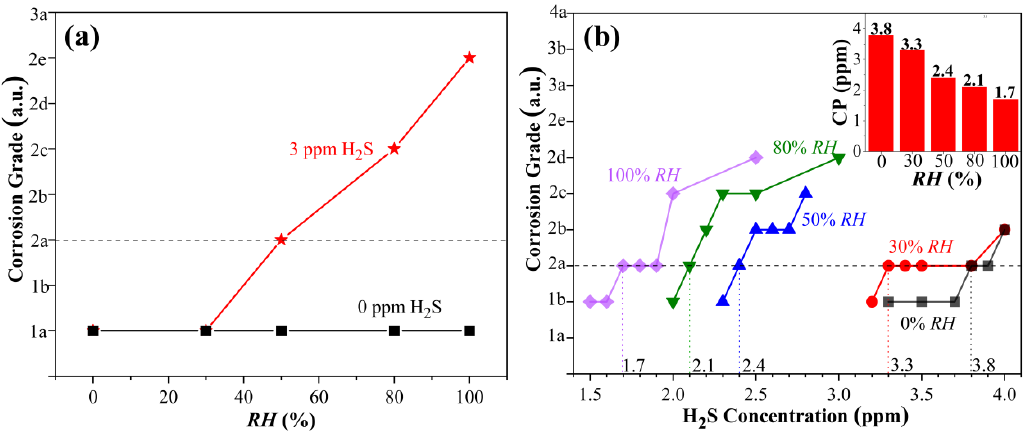
Figure 1. ( a ) Variation in copper corrosion grade in H 2 S-containing LPG with humidity; ( b ) the influence of H 2 S concentration and RH on the corrosion grade of copper in LPG.